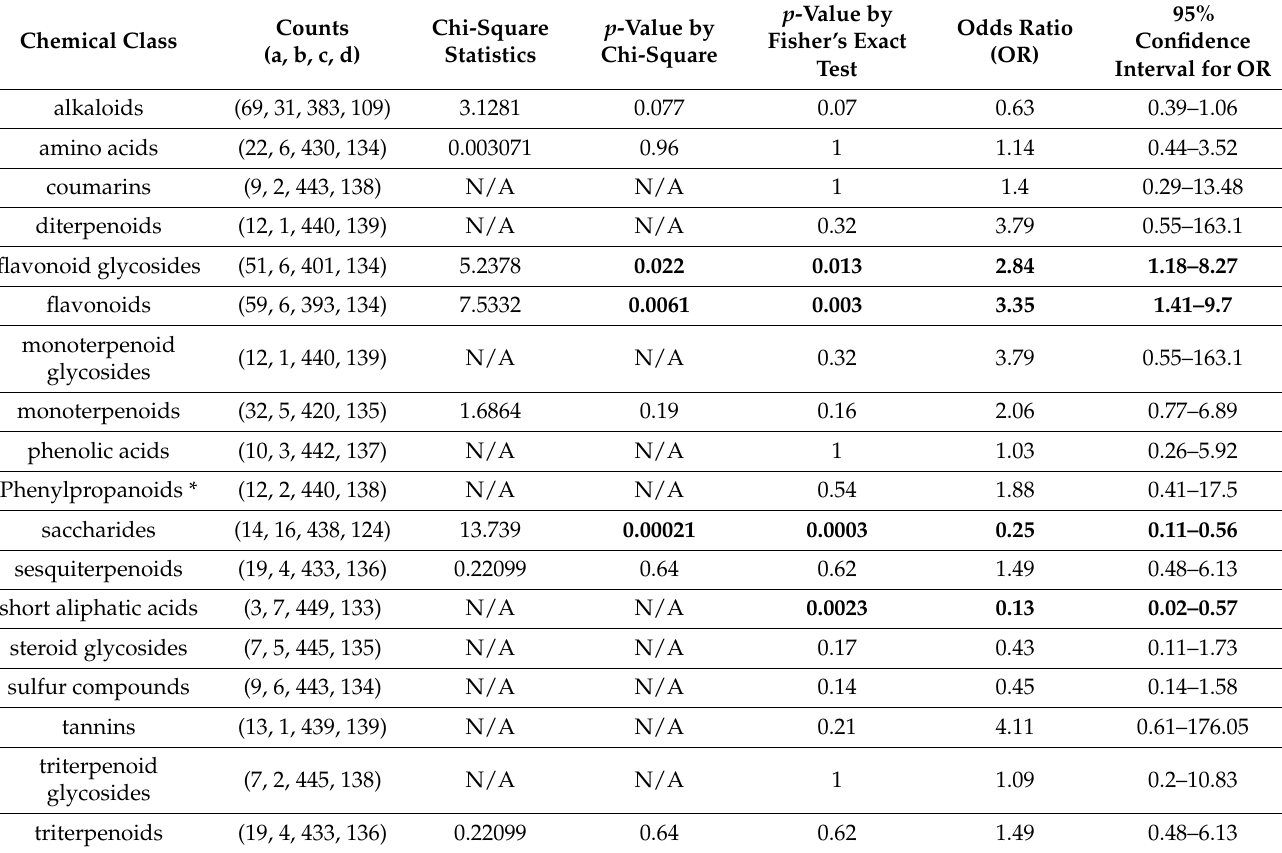
Table 2. The correlation between anti-inflammatory activity and chemical class. Legend: AIA— anti-inflammatory activity, chemClass—chemical class; N/A—not applicable; Note. The second column contains the number of phytocompound in each of the 4 cells of the 2 × 2 tables used for performing Chi-square test and/or Fisher’s exact test: a = chemClass + AIA+, b = chemClass + AIA −